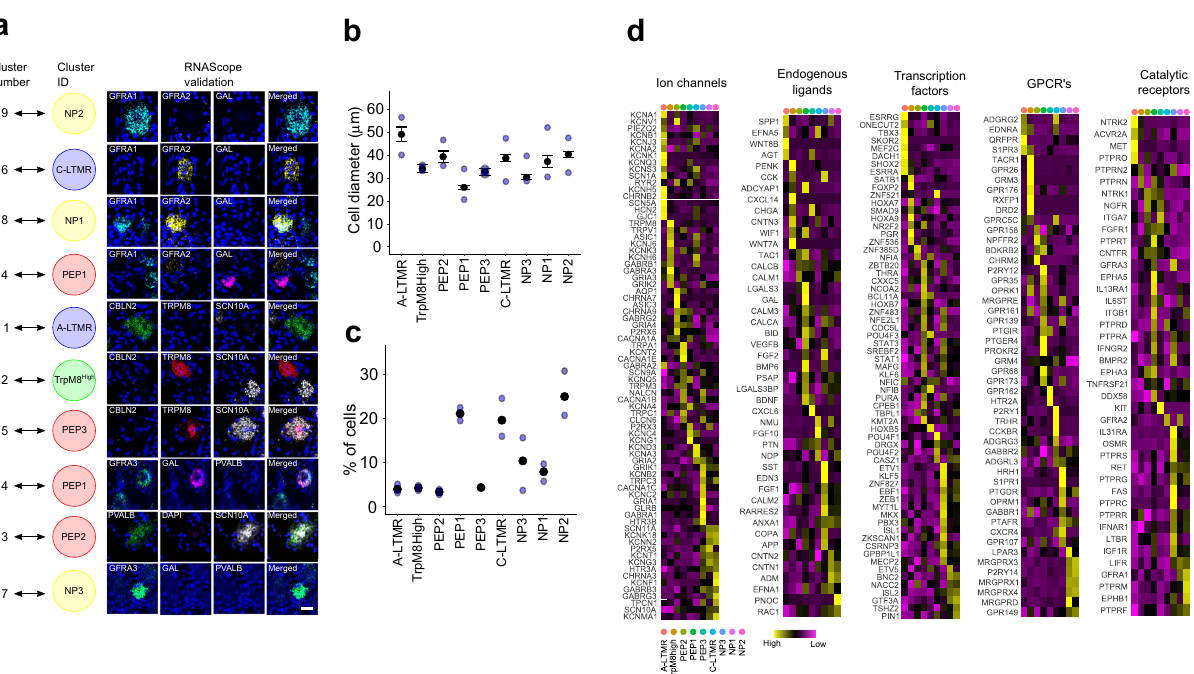
Fig. 4 In vivo validation and gene family expression in the macaque DRG neuron types. a Naming the macaque clusters after the closest corresponding mouse cell types (left) with RNAScope validations (right). Scale bar = 20 µ m. b Diameter of neuronal types in lumbar DRGs, mean ± SEM. c Percent of each neuronal type among neurons of all types identi fi ed in this study in lumbar DRG. In b , c , blue dots represent values for individual animals. d Heatmaps of gene expression pro fi les for selected gene families in the macaque STRT-2i-seq DRG neuron clusters. Source data for b , c are provided as a Source Data fi